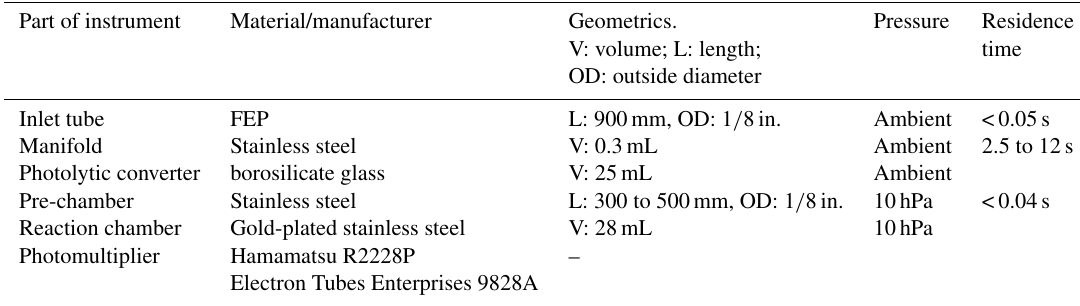
Figure 2. Schematic diagram of the IAGOS NO x instrument (Revision 2, certification in progress) showing all connections and modules. A more detailed view is shown in the Supplement (Fig. S1). O2S and SAD: assembly with magnetic valves and capillaries for distribution of oxygen and synthetic air to different parts of the instrument. NOD: chemiluminescence detector. O3G: ozone generator. VAC: two membrane pumps for the gas flow of the system. ICC: internal calibration and converter unit, containing the manifold, photolytic converter, flow controller and permeation source. In Revision 1 only O 2 is used for the internal stability checks during flight, while in Revision 2 this is replaced by synthetic air. O 2 is then only used for the ozone generator. Table 1. Overview of the main instrument components and their specification.